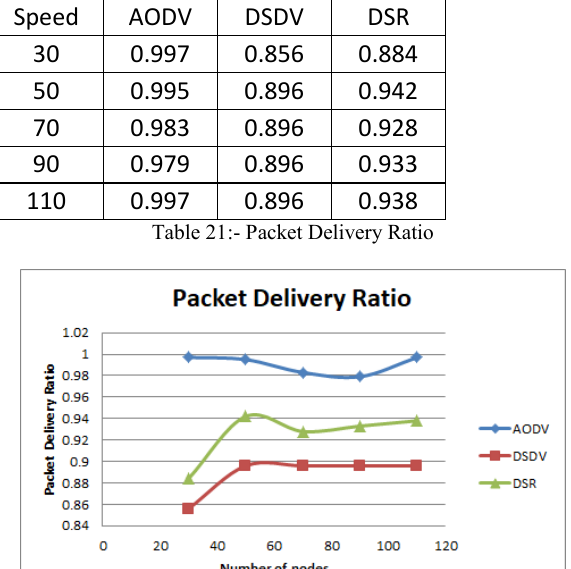
Table 19:- Packet loss